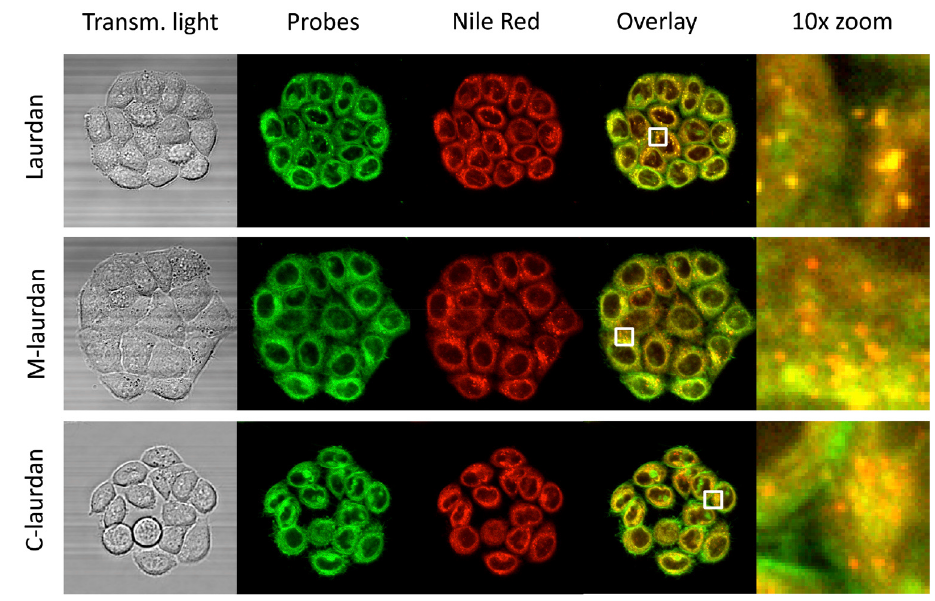
Figure 3. The intra-cellular vesicles labelled by Laurdan co-localize perfectly with Nile Red labelling, which labels lipid droplets. Hela cells were grown on glass coverslips for four days before double-labelling with Nile red and either Laurdan (first line), M-laurdan (second line) or C-laurdan (third line), as described in M&M. The live cells, kept at 37°C, were then imaged over 30 channels: 29 fluorescence channels spanning from 420 to 700 nm, plus transmitted light (First column). The stacks were then used to perform spectral deconvolution with the poisson NMF pluggin, using the spectra acquired with cells labelled with only one probe as references. The second column: shows the signals allocated to the Laurdan-family probes, artificially coloured in green. The third column shows the signals allocated to Nile red, artificially coloured in red. The fourth column shows an overlay of the two signals, and the fifth column shows 10× zooms corresponding to the white squares in the fourth column. Width of the squares: 10 µm.